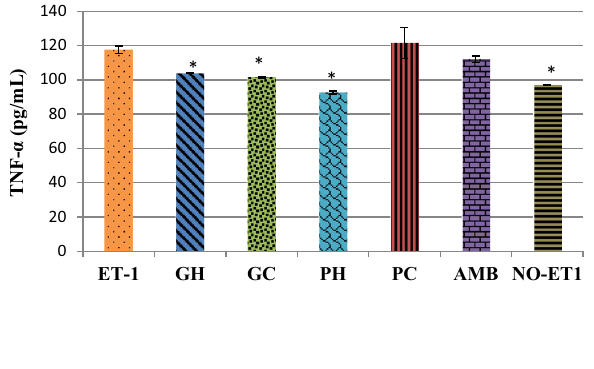
Figure 4. Effects of the hot-water (GH) and cold-water (GC) extracts of P. cubensis and hot-water (PH) and cold-water (PC) extracts of Pan cyanescens mushrooms (50 μg/mL) and positive control (AMB) ambrisentan (25 μg/mL) on levels of TNF-α after 48 h treatment repeated in three different times